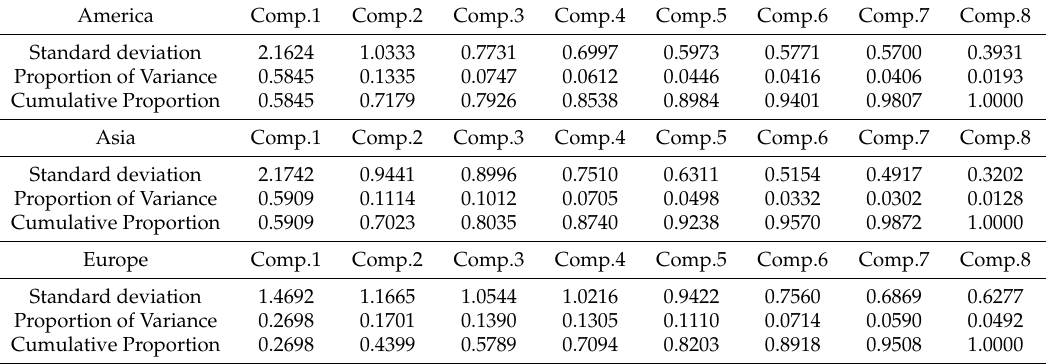
Table 12. PCA variance proportions with real exchange currency data (1/3/2013 to